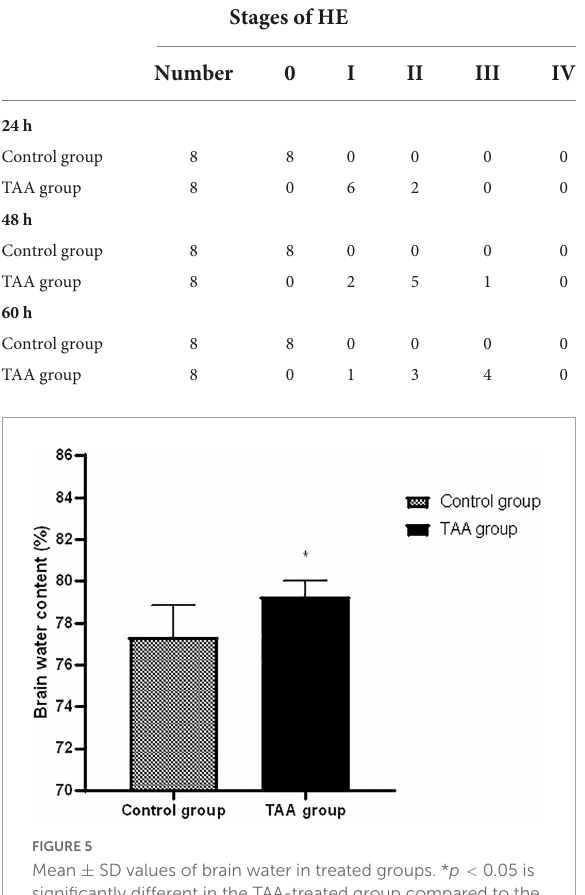
TABLE 2 Stages of hepatic encephalopathy (HE).